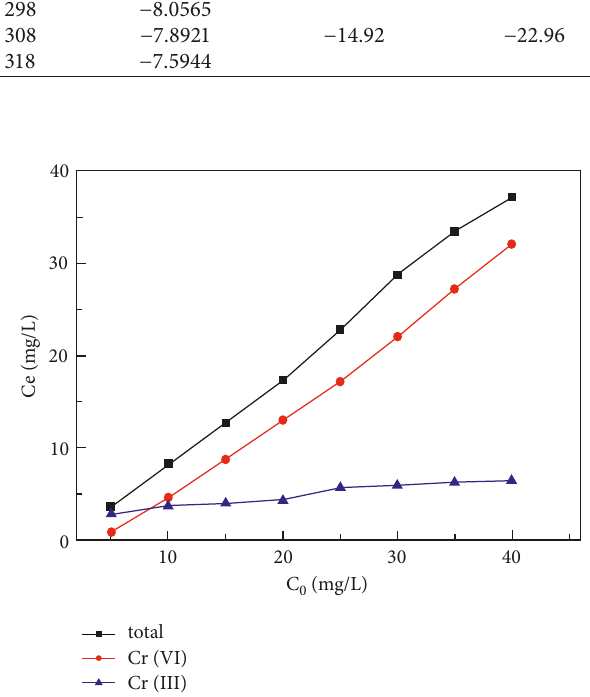
Figure 6: Residual concentration of Cr (total, VI, and III) after reaction in